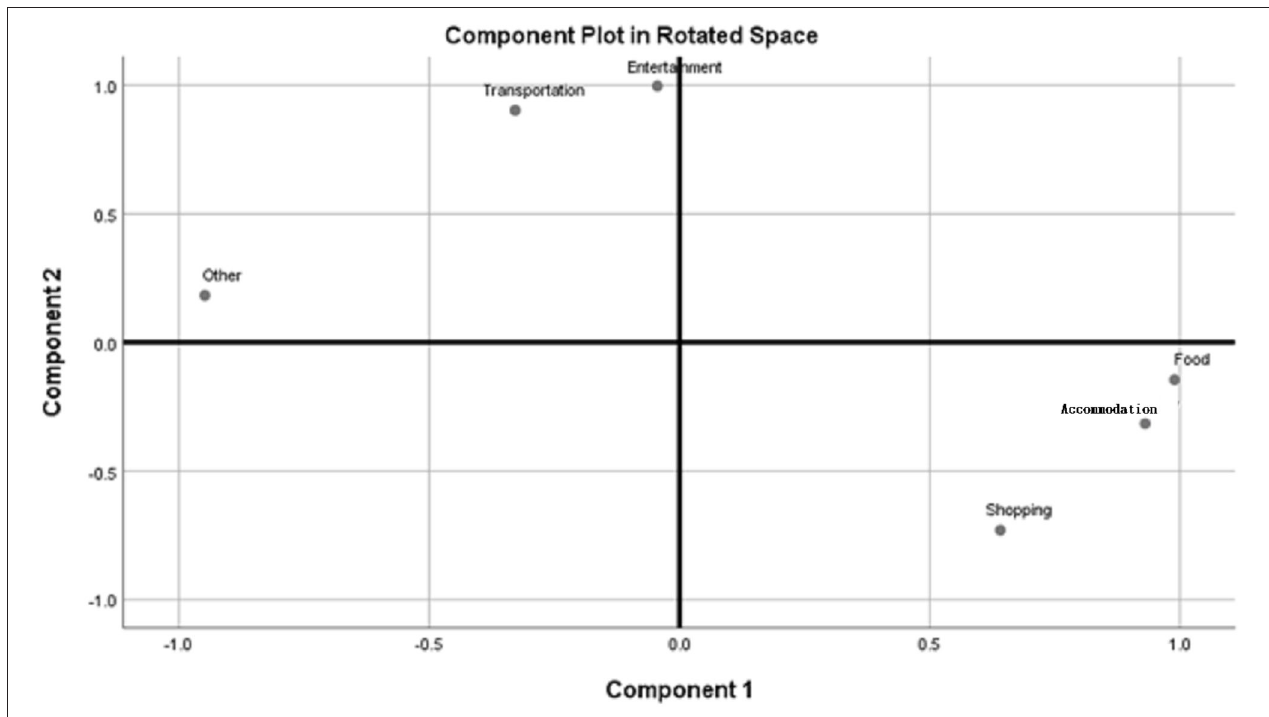
FIGURE 9 | The PCA analysis results of tourism